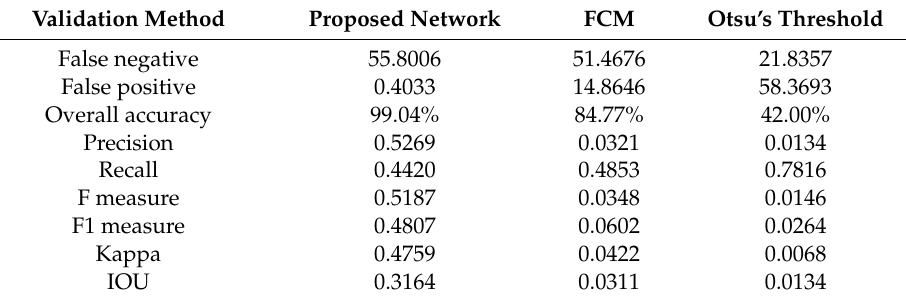
Figure 10. Results of the Bangkok site in the second area. The resolution of each image is 6 km × 6 km (for SAR pairs 27 November 2008/15 January 2010 and 12 January 2009/21 November 2009, respectively: (a, c ) Time 1 SAR image, ( b , d ) Time 2 SAR image, ( e , g ) ground truth, ( f , h ) proposed result, ( i , k ) result of FCM, ( j , l ) result of Otsu). Table 5. Accuracy of each model in the Bangkok area. FCM—fuzzy